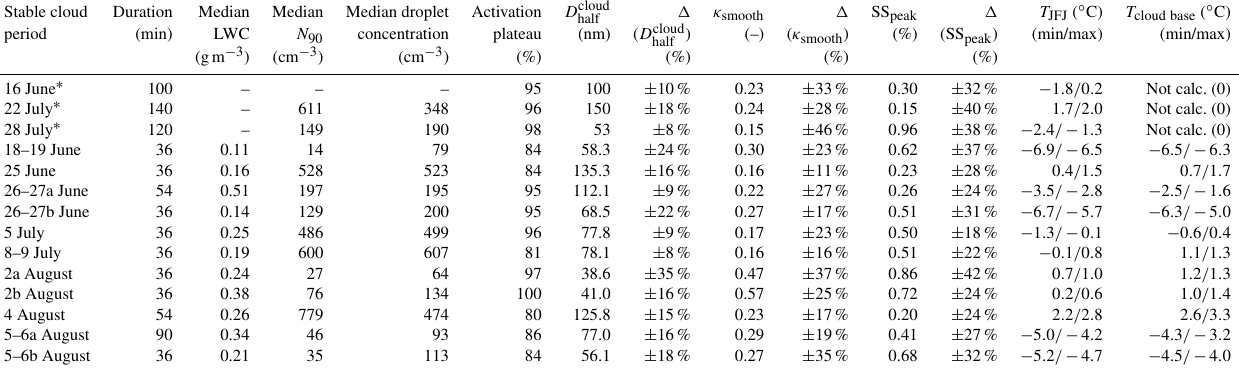
Table 1. Parameters for all 14 stable cloud periods further analysed in this study (3 from CLACE2010 where names are associated with an asterisk, 11 from CLACE2016). N 90 is the number concentration of potential CCN, i.e. particles with a mobility diameter larger than 90nm. The droplet number concentration is estimated based on the difference between the particle number concentrations measured behind the total and the interstitial inlets. κ smooth refers to the moving average the CCN-derived hygroscopicity parameter κ time series (see Sect. 3.5). The 1 σ uncertainties are indicated by the symbol “ (cid:49) ”. Values of T cloud base are the temperatures that were used for calculating SS peak . Stable